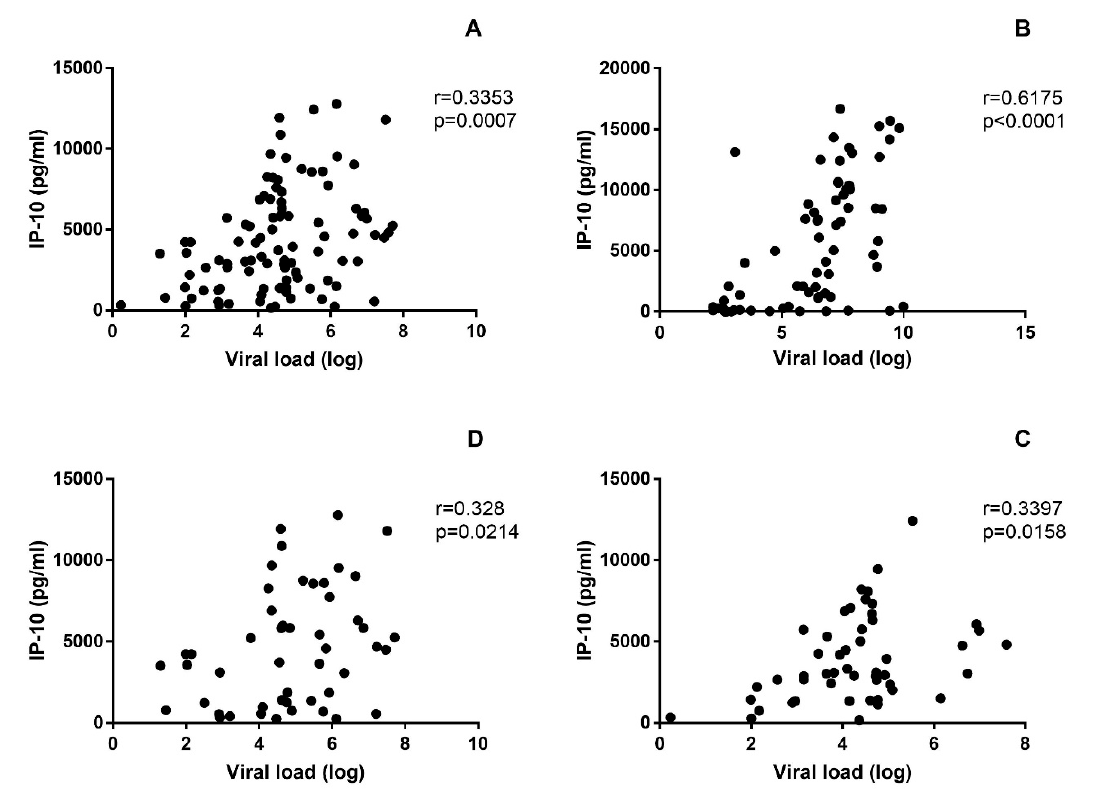
Figure 6. Correlation between biomarker IP-10 and viral loads of HFRS patients ( A ), CCHF patients ( B ), patients infected with DOBV ( C ) and patients infected with PUUV ( D ). Nonparametric two-tailed Spearman correlation test with 95% confidence interval was used.